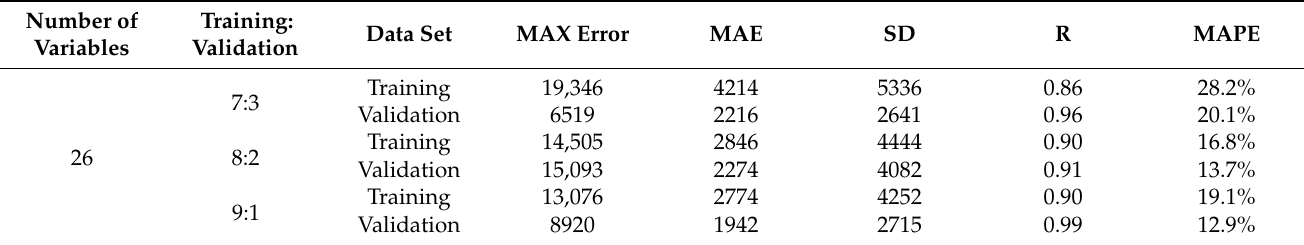
Table A5. Analysis of the results of the RBFN model for electricity